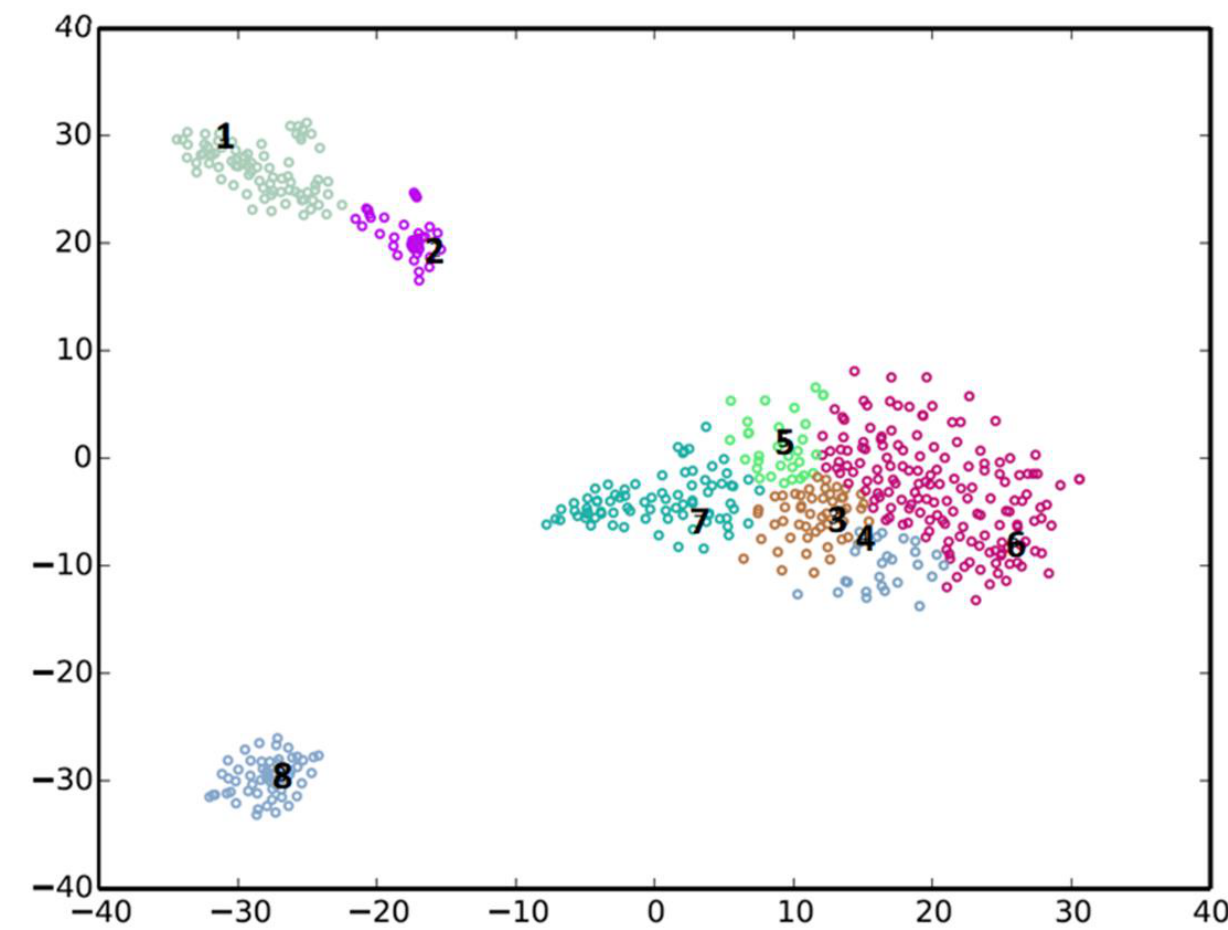
Figure 1. Metagenomic binning of contigs using the MyCC analysis tool [29].